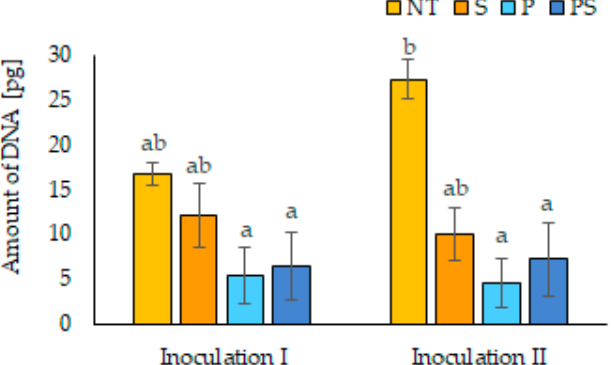
Figure 4. The amount of Fusarium DNA in plant tissue of maize juvenile plants grown in the contaminated soil in pg per 50 ng of total DNA. (NT–not treated seeds, S–seeds coated with SAP, P– seeds dressed with pesticides, and PS–seeds dressed with pesticides and coated with SAP). The errors of the mean values are expressed as standard deviation ( ± SD). Different letters indicate statistically significant differences by LSD test ( α = 0.05).